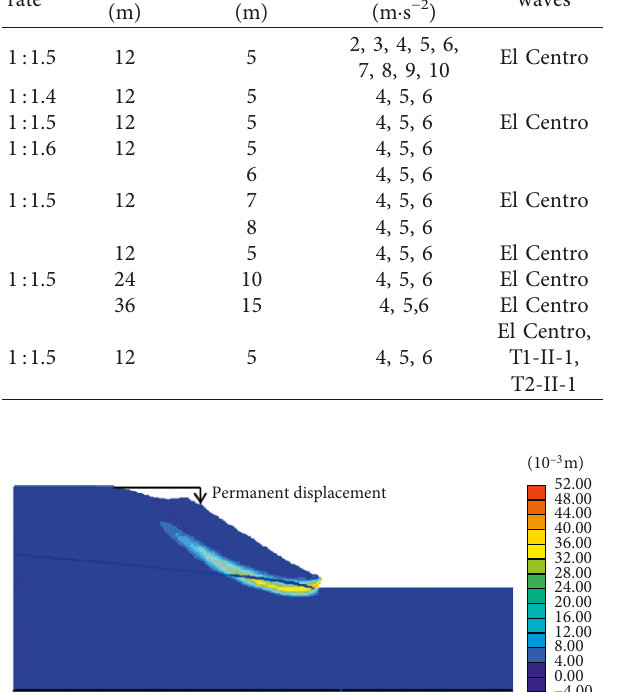
Figure 4: Permanent displacement calculated by the finite element